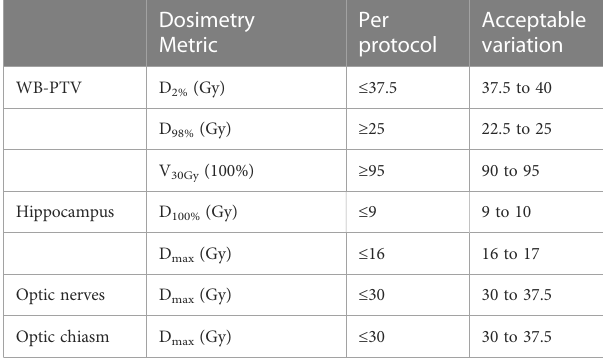
TABLE 1 Dose criteria of RTOG 0933